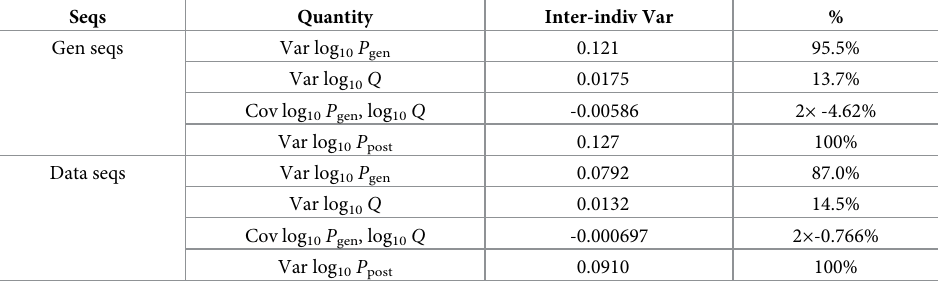
Table 2. Inter-individual